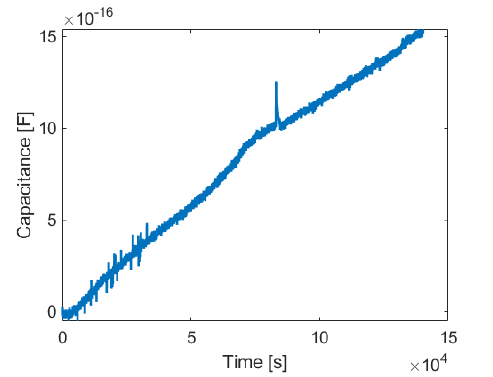
Figure 10. Experimental results for ice accretion on the sensor surface in the climate chamber experiment. The capacitance difference in one of the electrodes caused by the ice accretion at constant temperature is shown.